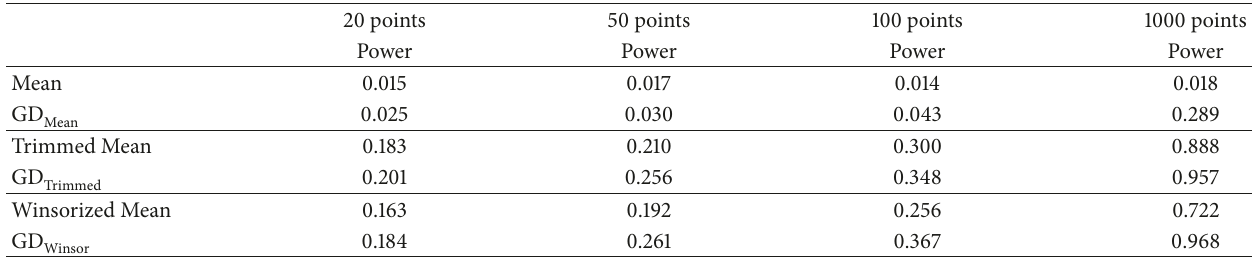
Table 13: Log-normal distributions with 30% noise level.